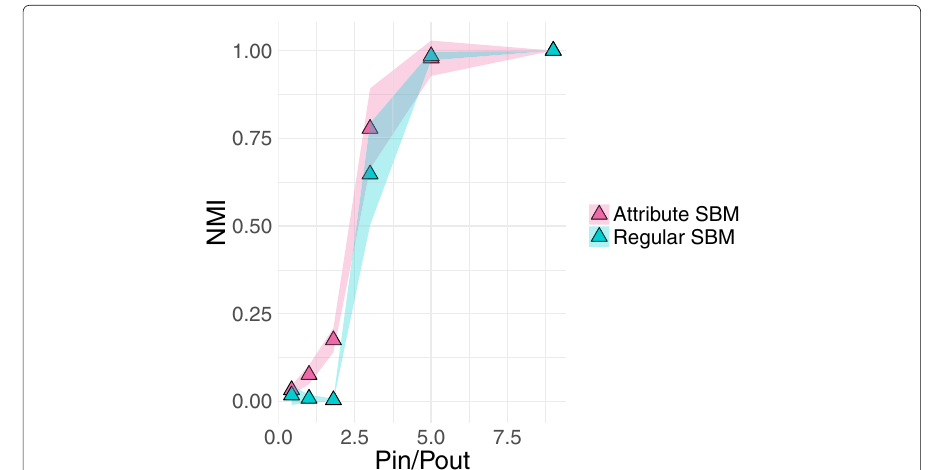
Fig. 3 Detectability Analysis in Synthetic Example. To understand how attribute information can be combined with connectivity to assign nodes to communities accurately, we generated synthetic networks for within-probabilities of p in between 0.05 and 0.3 with corresponding p out or between-community probabilities such that the mean degree of the network was 20. For each of these synthetic networks, we used the attributes from the analysis in Fig. 2 to fit the attributed SBM. Here, we plot the correctness of the node-to-community assignment with normalized mutual information using the partition obtained from regular SBM (blue) and the partition under the attributed SBM model fit (pink). For each combination of p in and p out , we generated 10 networks and hence the bands around the points denote standard deviation. Incorporating attributes with the attributes stochastic block model improves results, particularly near and below the detectability limit, and appears to smooth out the sharp phase